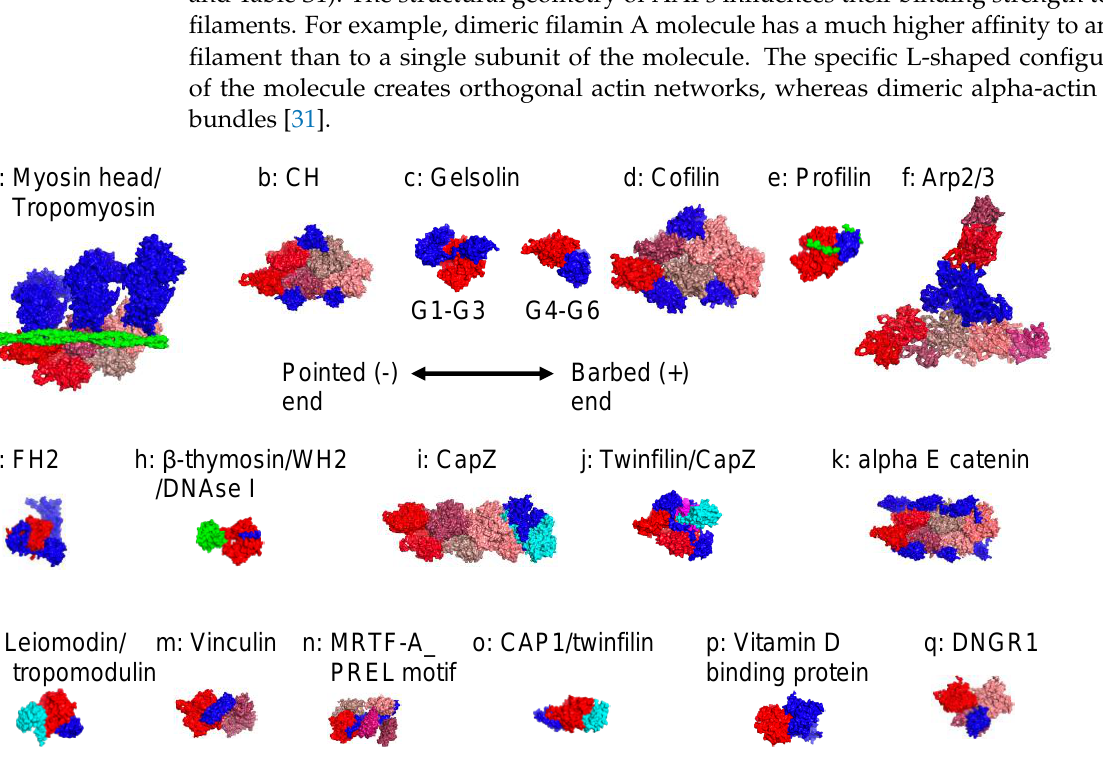
Figure 3. Surface models of the actin – ABP complexes: ( a ) Myosin motor domain (Cardiac myosin, 7JH7, tropomyosin is shown in green [47]). ( b ) CH domain (Utrophin, CH1, 6M5G [54]). ( c ) Gelsolin domain (gelsolin G1_G3, 1RGI [78], G4_G6, 1H1V, [79]). ( d ) Cofilin (5YU8 [57]). ( e ) Profilin (profilin, 2PBD [58], VASP is shown in green). ( f ) Actin-related protein (Arp2/3/actin, 7AQK, [60]). ( g ) Formin homology 2 (FH2) domain (Yeast Bni1p/actin, 1Y64 [62]). ( h ) β -Thymosin/WH2 domain (Wiskott – Aldrich syndrome protein (WASP), 2A3Z [64], DNAse I is shown in green). ( i ) Capping protein (CapZ, 7PDZ [65], CapZ alpha-1 is shown in cyan; CapZ beta is shown in blue). ( j ) Twinfilin and CapZ (7CCC [66], CapZ alpha- 1 is shown in cyan; CapZ beta is shown in magenta). ( k ) Alpha E catenin (6WVT [67]). ( l ) Leiomodin and tropomodulin (4Z94 [68], leiomodin is shown in blue; tropomodulin is shown in cyan). ( m ) Vinculin (3JBI [70]). ( n ) MRTF-A PREL motif (2YJF [71]). ( o ) Cyclase-associated protein CAP1 and cofilin (6RSW [72], CAP1 is indicated in blue; twinfilin is indicated in cyan). ( p ) Vitamin D binding protein (1MA9 [73]). ( q ) DNGR1 (3J82 [74]). Actin in F-actin is shown from pointed (left) to barbed (right) end with red, tv red, raspberry, dark salmon, salmon, deep salmon, warm pink, and firebrick. ABPs are shown in blue. DNAse I is shown in green.